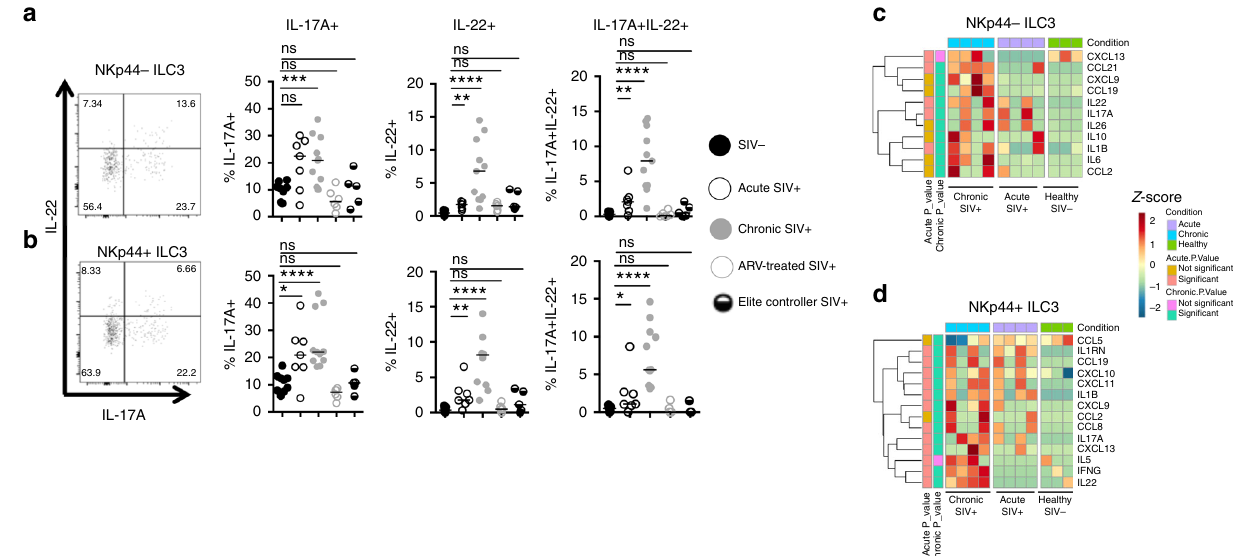
Fig. 5 SIV infection is associated with signi fi cant functional changes in MLN ILCs. Mesenteric lymph node mononuclear cells from healthy ( N = 7), acute ( N = 7), chronic ( N = 9), ART-treated ( N = 6), or EC SIV-infected animals ( N = 5) were stimulated for 6 h with PMA/ionomycin. Intracellular IL-17A and IL-22 expression was measured in NKp44 − ( a ) or NKp44 + ( b ) ILC3. Gene expression pro fi les of selected cytokines and chemokines produced by NKp44 − ( c ) and NKp44 + ( d ) ILC3s in the SIV − ( N = 3) and the untreated acute ( N = 4) and chronic ( N = 4) SIV + MLN. Color scheme in both heatmaps represents number of standard deviations above (red) or below (blue) the mean. Statistical signi fi cance was determined by the Mann – Whitney test for a , b . Statistical signi fi cance of c , d was determined using the Wald test with Bonferroni correction for multiple comparisons. ns = P > 0.05, * = P ≤ 0.05, ** = P